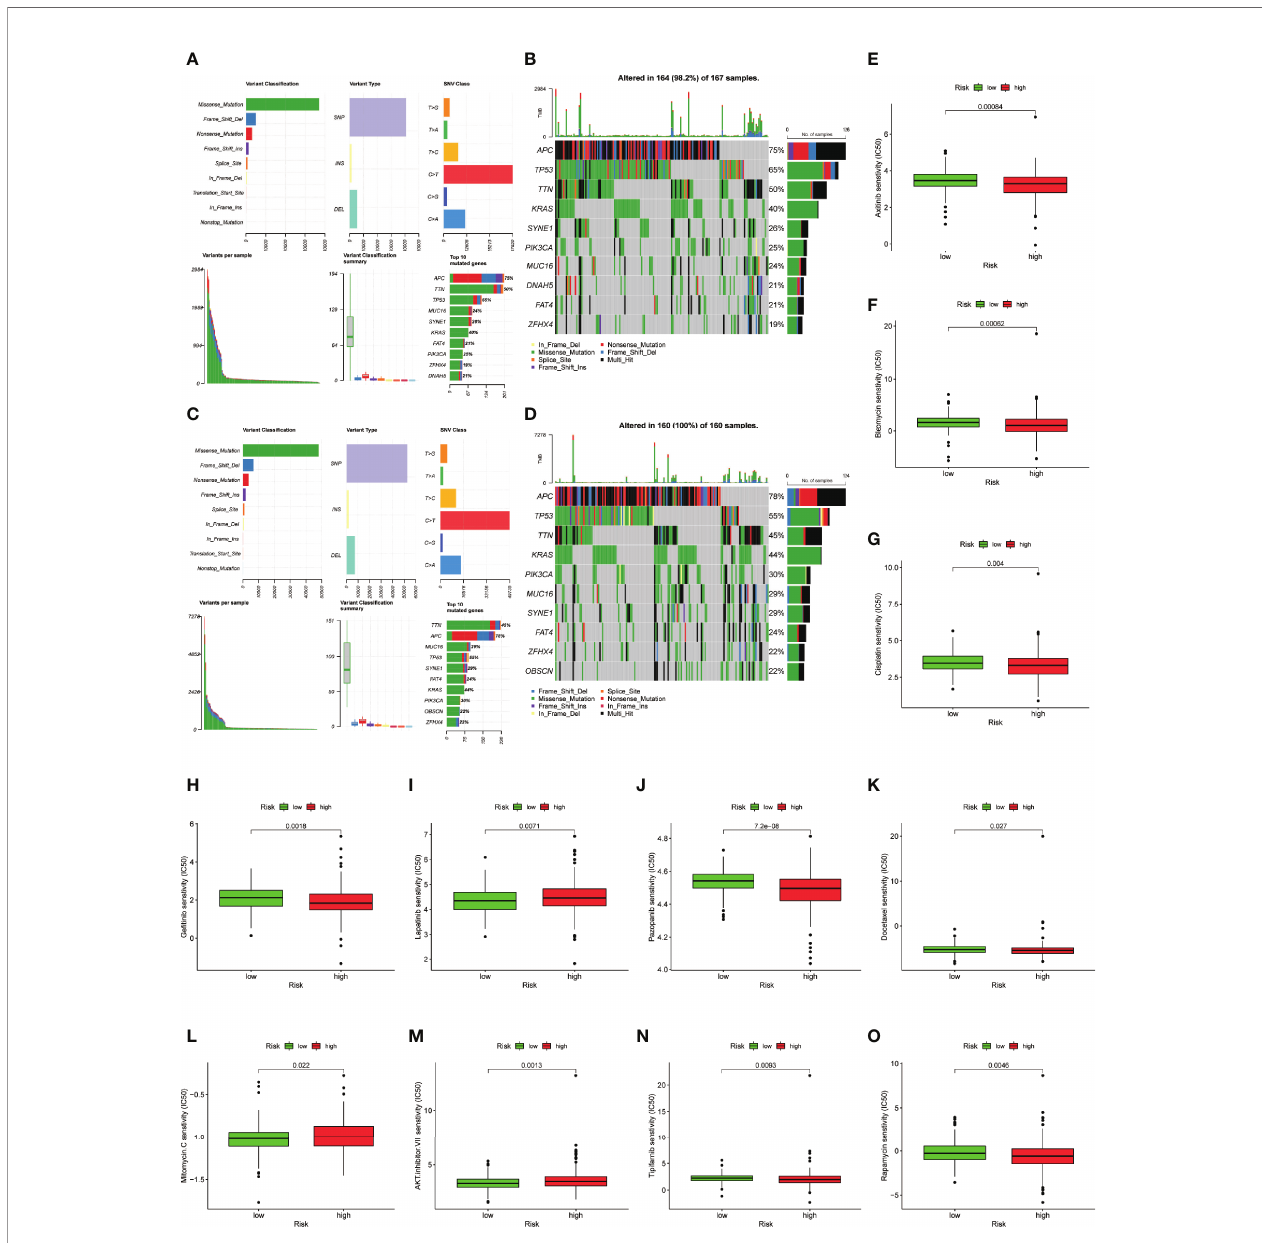
FIGURE 8 | Somatic mutation analysis and drug sensitive prediction in colon cancer patients. (A – D) MAF-summary plots and oncoplots of the somatic mutation showing the difference between the high-risk group and low-risk group in colon cancer patients. (E – O) Boxplot showing the mean differences in estimated IC50 values of 11 representative drugs (cisplatin, docetaxel, bleomycin, axitinib, ge fi tinib, pazopanib, rapamycin, tipifarnib, lapatinib, mitomycin C, AKT inhibitor VIII) between the two risk